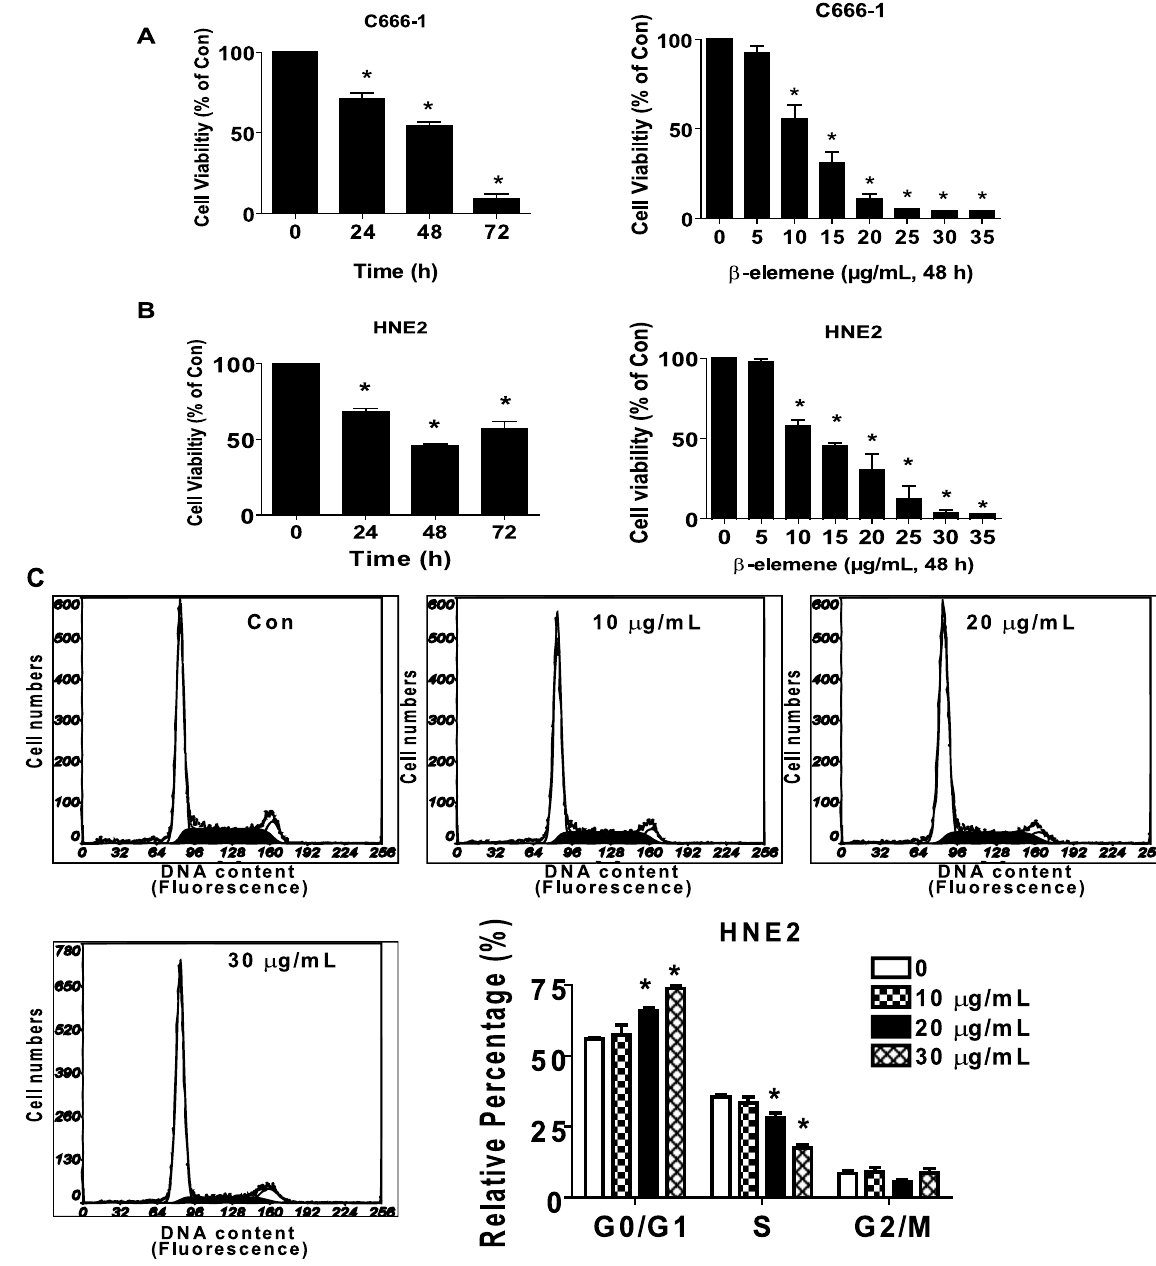
Figure 1. β -elemene inhibited growth and induced cell cycle arrest in NPC cells. ( A,B ) C666-1 ( A ) and HNE2 ( B ) cells were treated with increased concentrations of β -elemene for up to 48 h or to β -elemene (20 μ g/mL) for up to 72 h. ( C ) HNE2 cells were treated with indicated concentrations of β -elemene for 24 h. The cells were collected and processed for analysis of cell cycle distribution. Cell cycle was analyzed by flow cytometry after propidium iodide (PI) staining, and the percentages of the cell population in each phase (G0/G1, S and G2/M) of cell cycle were analyzed by Multicycle AV DNA Analysis Software. Data are expressed as a percentage of total cells. Values are given as the mean ± SD, from 3 independent experiments performed in triplicate. * Indicates significant difference as compared to the untreated control group (P <